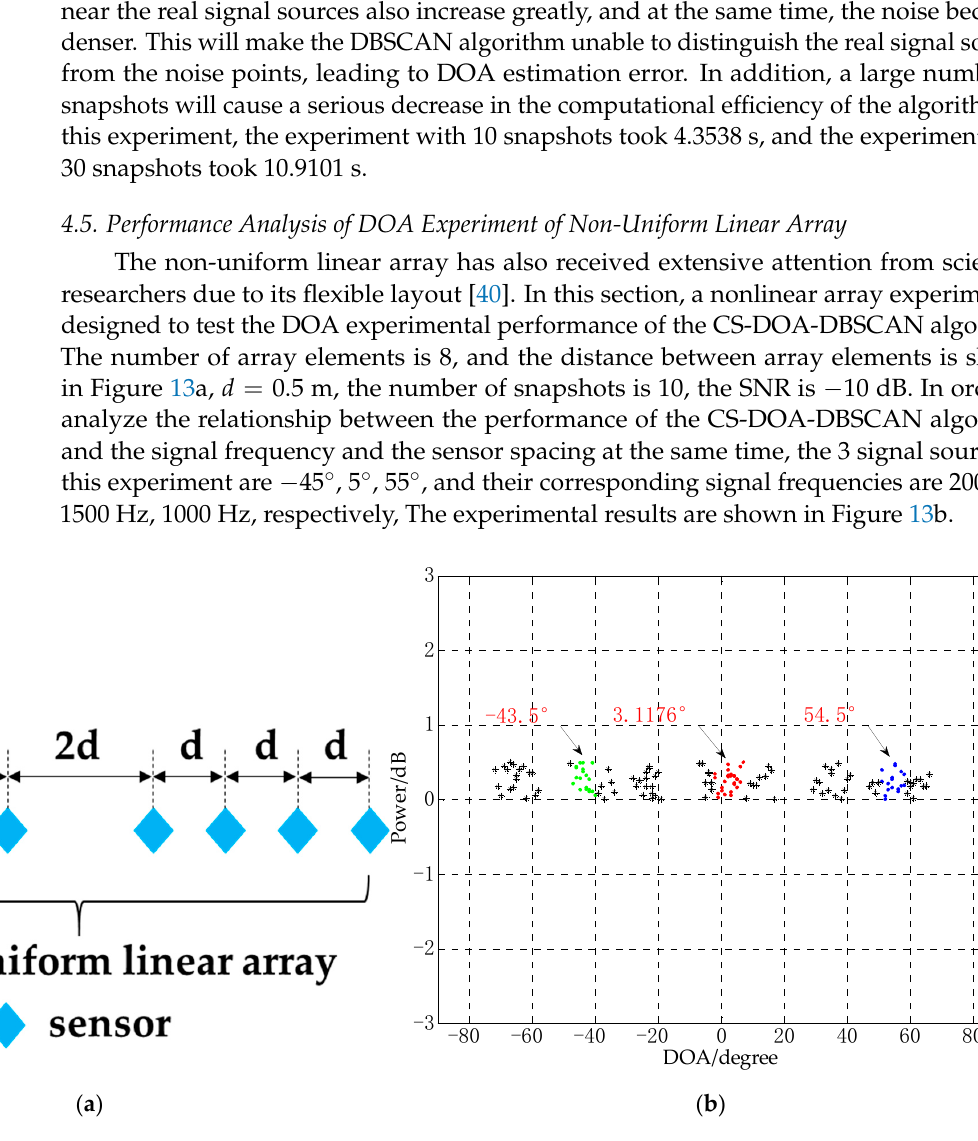
Figure 13. Non-uniform linear array DOA estimation experiment, ( a ) array model; ( b ) DOA experiment.